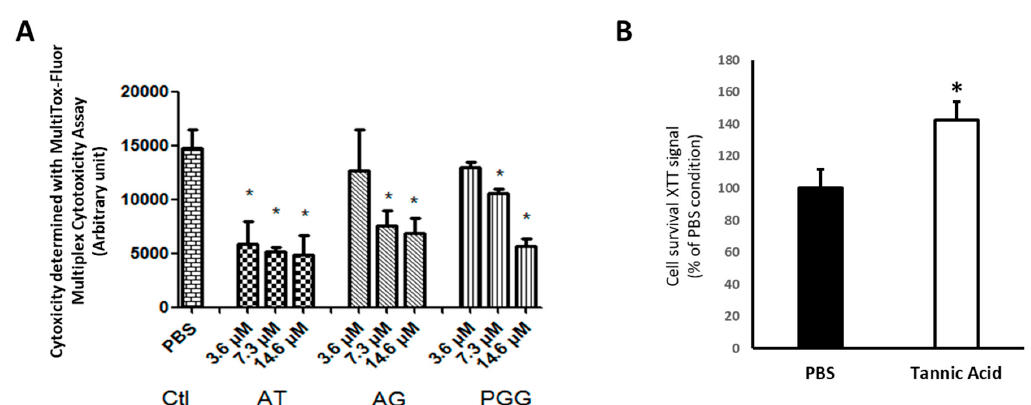
Figure 8. Tannic acid and derivatives protect endothelial cells from hypoxia–reoxygenation injury. ( A ) Cytotoxicity induced by the hypoxia–reoxygenation sequence was prevented by tannic acid (AT) and its main metabolites gallic acid (GA) and penta-O-galloyl-beta-D-glucose (PGG) with a dose-dependent response. Molecules were added in the culture medium during the hypoxia–reoxygenation sequence. n = 3, n = 2. ( B ) XTT analysis showing that cytotoxicity induced by the hypoxia–reoxygenation sequence was prevented by tannic acid (12.5 mg/mL, 7.3 µmol/L). Molecules were added in the culture medium during the hypoxia–reoxygenation sequence. n = 3, n = 2, values are mean ± SD, * p < 0,05 to the PBS condition (vehicle).